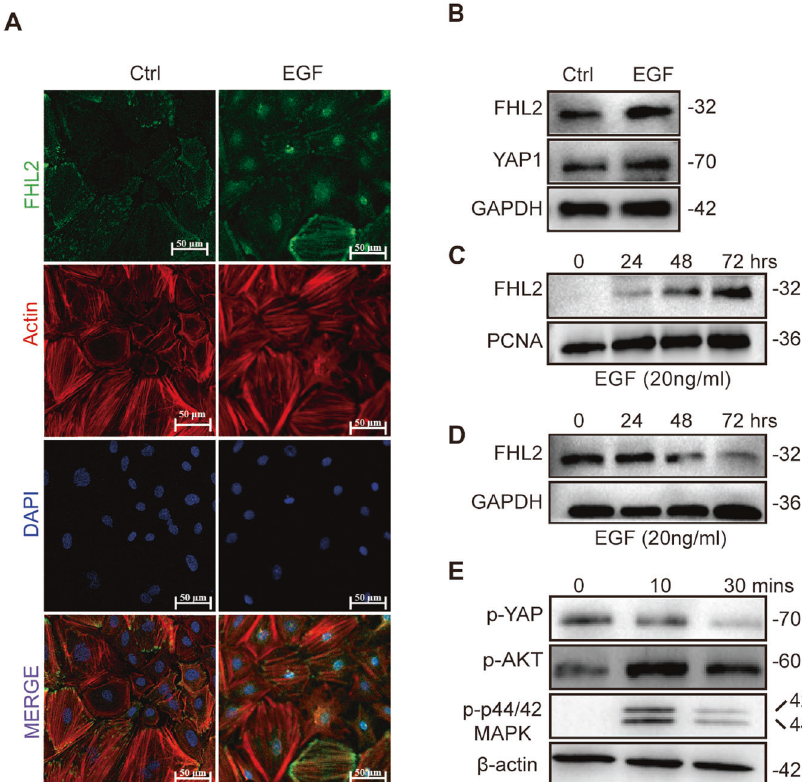
Fig. 6 EGF Treatment Induced FHL2 and YAP1 Expression and Translocation. A Immuno fl uorescence staining showing FHL2 expression and subcellular location in vitro. Primary GCs were isolated and cultured with absence (vehicle control, Ctrl) or presence of 20 ng/ml EGF (EGF) for 48 h. Immuno fl uorescence staining was used to identify the subcellular location of FHL2. The FHL2 immunosignal was presented in green and F-actin (phalloidin) was presented in red color. Nuclei were stained with DAPI (blue). Scale bar: 50 μ m. B FHL2 and YAP1 protein expression in GCs treated in absence (vehicle control, Ctrl) or presence of EGF (20 ng/ml). GAPDH was used as a loading control. C , D Western blot images showing FHL2 expressions in the nucleus ( C ) or cytoplasm ( D ) of GCs. GCs were incubated with absence (vehicle control, Ctrl) or presence of EGF (20 ng/ml) for 24 h, 48 h or 72 h in vitro. Nuclear and cytoplasmic protein were isolated to analyze FHL2 expression by western blot. PCNA was used as a nuclear protein loading control. GAPDH was used as a cytosol protein loading control. E EGF treatment stimulated the active form of YAP1. GCs were incubated with 20 ng/ml EGF for 0, 10 or 30 min. Phosphorylated protein levels were determined using western blot. β -actin was used as a loading